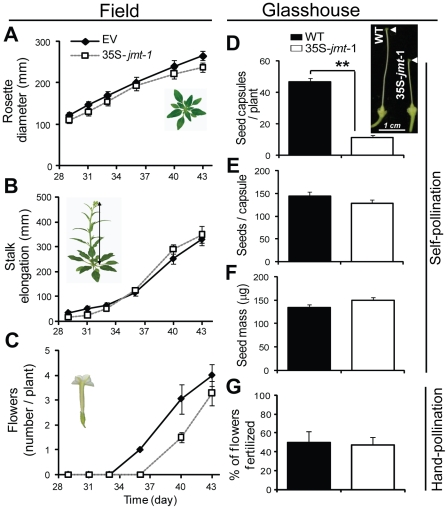
35S-jmt-1 plants develop as EV plants in nature but produce fewer seed capsules in the glasshouse due to impaired self-pollination.Mean (± SD, 15 to 49) rosette diameter (A) and stalk length of 35S-jmt-1 compared to EV plants (B). Appearance of first flowers (C) is delayed for 35S-jmt-1 plants. Mean capsule number (± SD, n = 6) (D), seed number per capsule (± SD, n = 25) (E) of the first four to five ripe self-pollinated capsules per plant of each genotype and seed mass (F). (G) Flowers of 35S-jmt-1 plants, which have reduced style length [26] (insert in panel D) produced WT numbers of seed capsules after hand-pollination with equivalent amounts of pollen. Asterisks indicate significant differences between empty-vector (EV) or WT and 35S-jmt-1 plants (unpaired t-test; ** P<0.001).